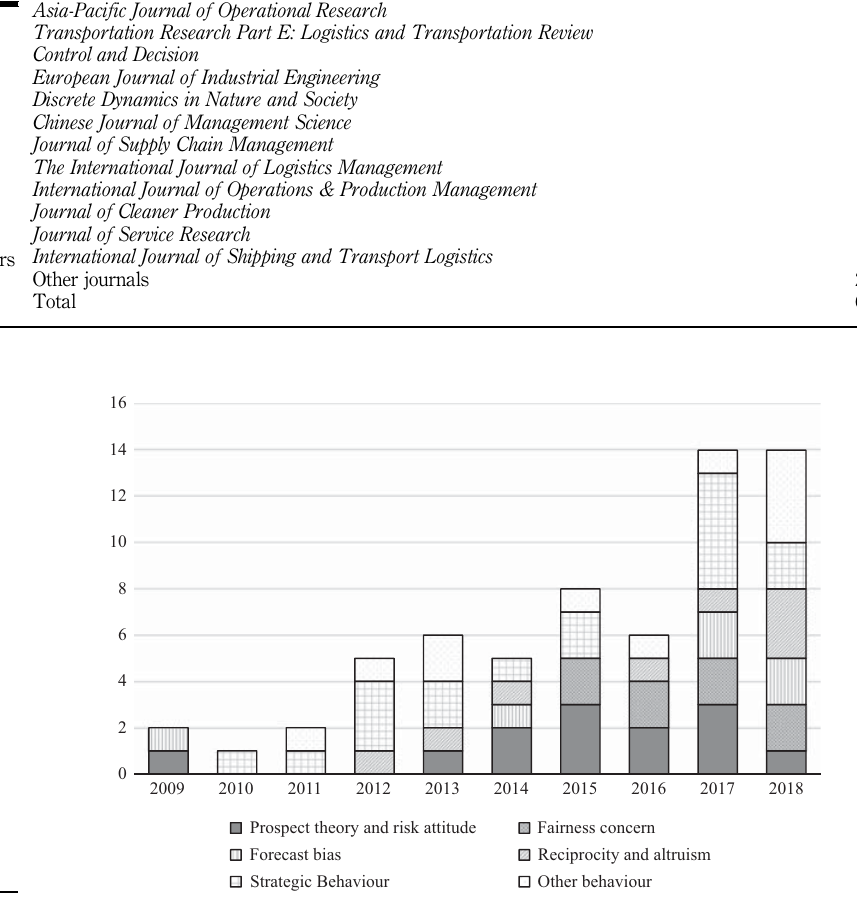
Figure 2. Analysis of research topics, 2009 –